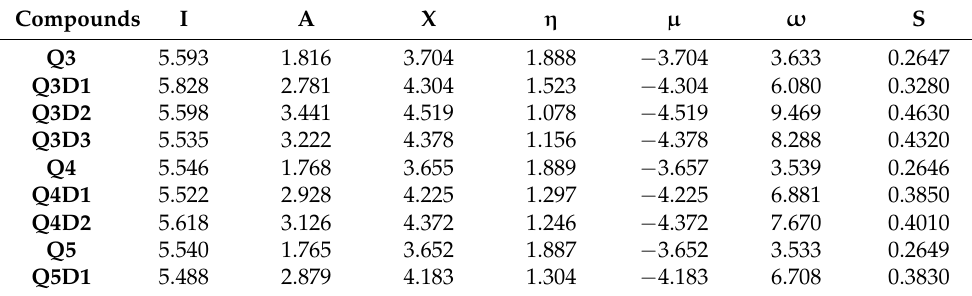
Table 2. Calculated global reactivity parameters using the energies of HOMO and